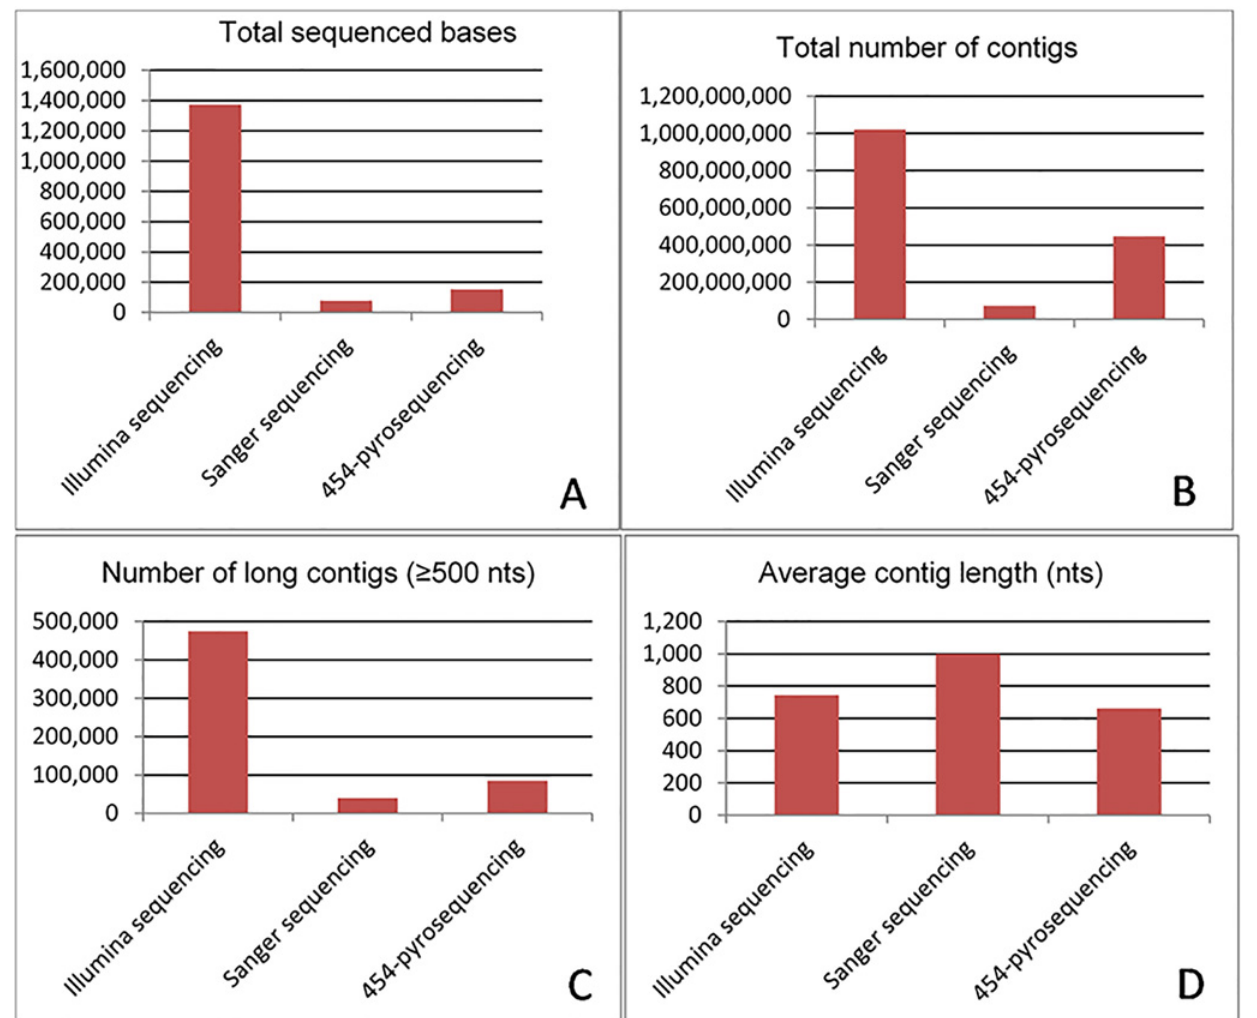
Fig 2. Comparison of total number of sequenced bases (A), total number of contigs (B), number of long contigs ( (cid:1) 500 bp) (C), and average length of contigs (D) obtained from Illumina, Sanger-based, and 454-pyrosequencing techniques. Data on Sanger-based and 454-pyrosequencing techniques were obtained from Salem et. al